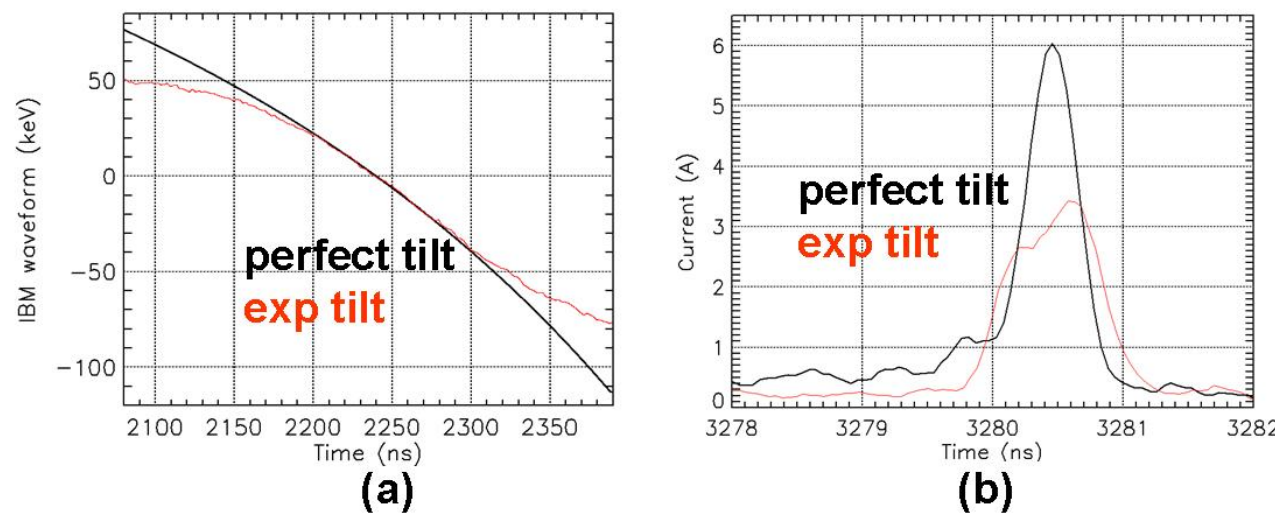
FIG. 3. (Color) In (a) the experimental and ideal IBM voltage waveform are plotted. The resulting beam currents at z (cid:5) 415 cm are shown in (b). The transported current is 27